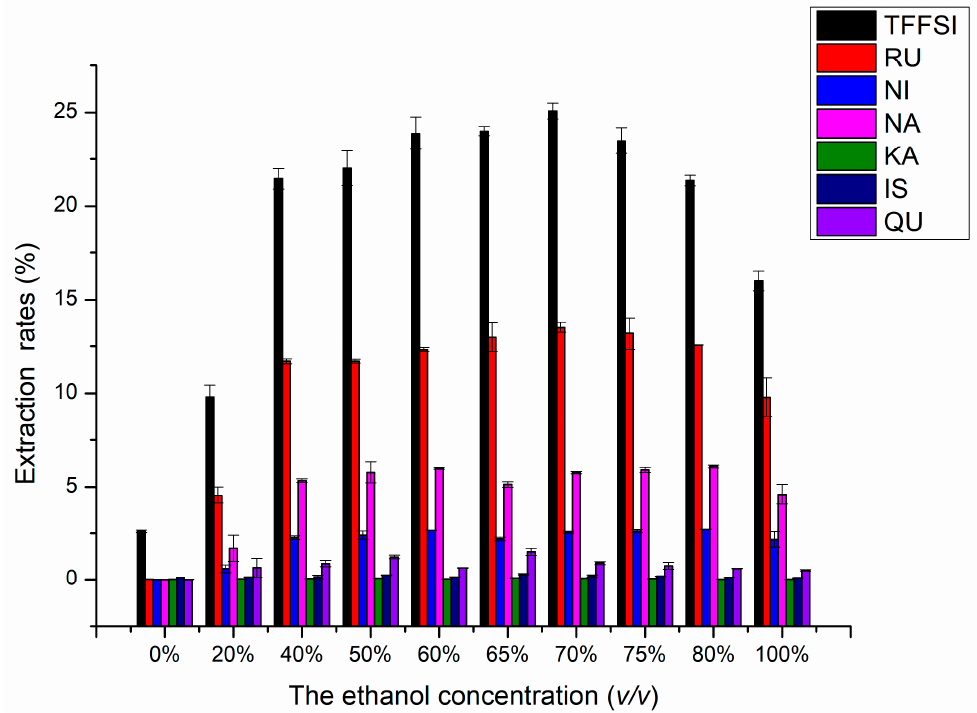
Figure 3. E ff ects of the ethanol concentration on the extraction rates of RU, NI, NA, KA, IS, QU, and the TFFSI.